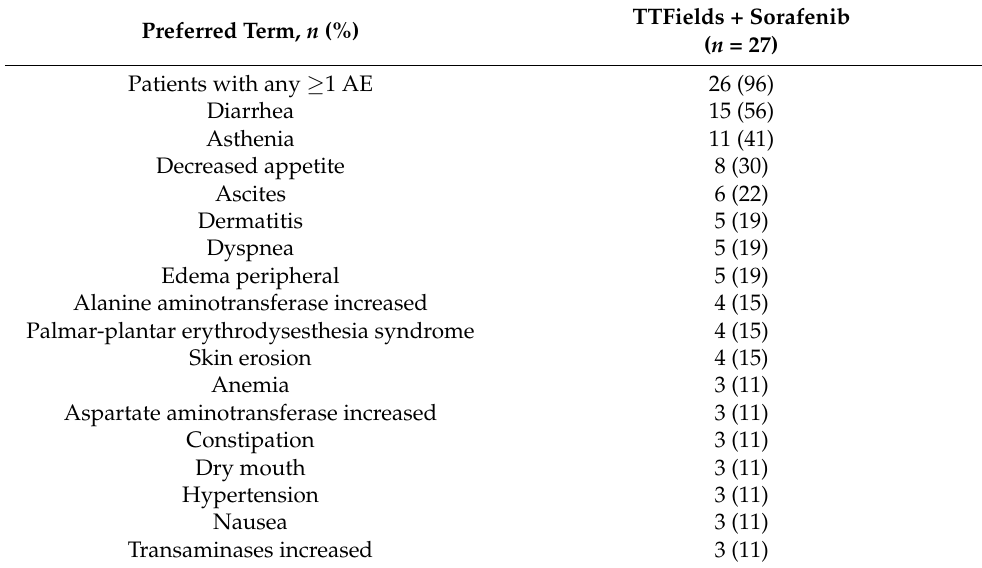
Table 4. All AEs occurring in >10% of patients treated with TTFields concomitant with